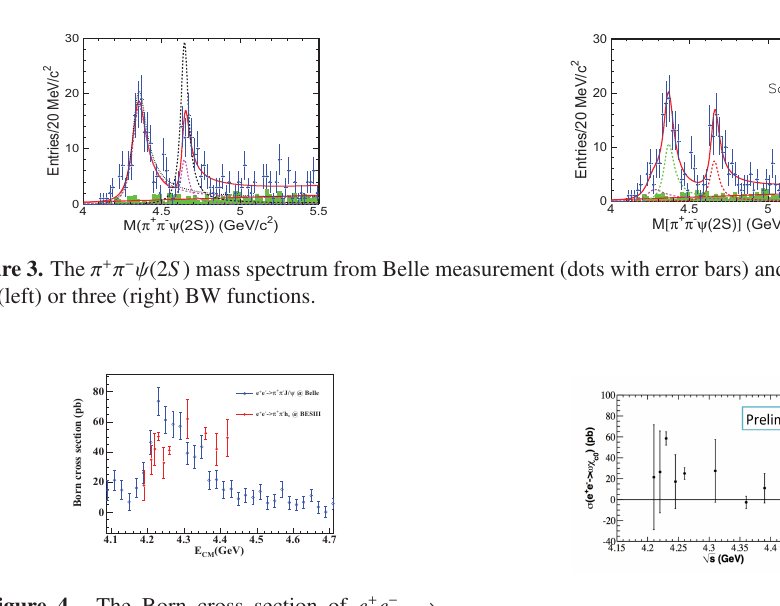
Figure 5. The Born cross section of e + e − → ωχ c 0 at di ff erent energy points from 4.21 to 4.42